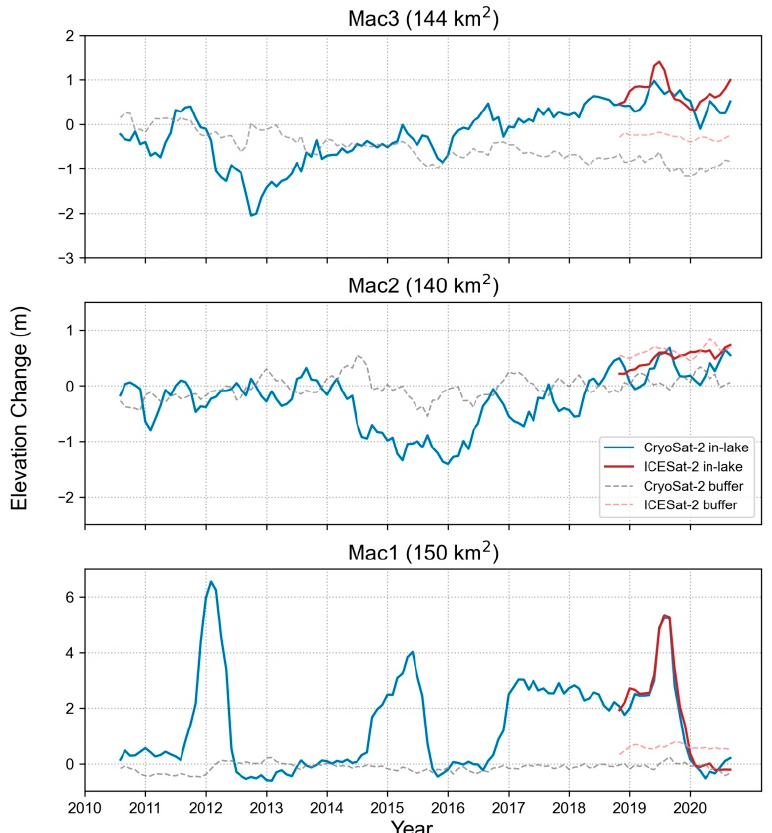
Figure 5. Time series of the ice surface elevation changes of the subglacial lakes beneath the MacAyeal Ice Stream. The subplots are arranged from upstream to downstream.